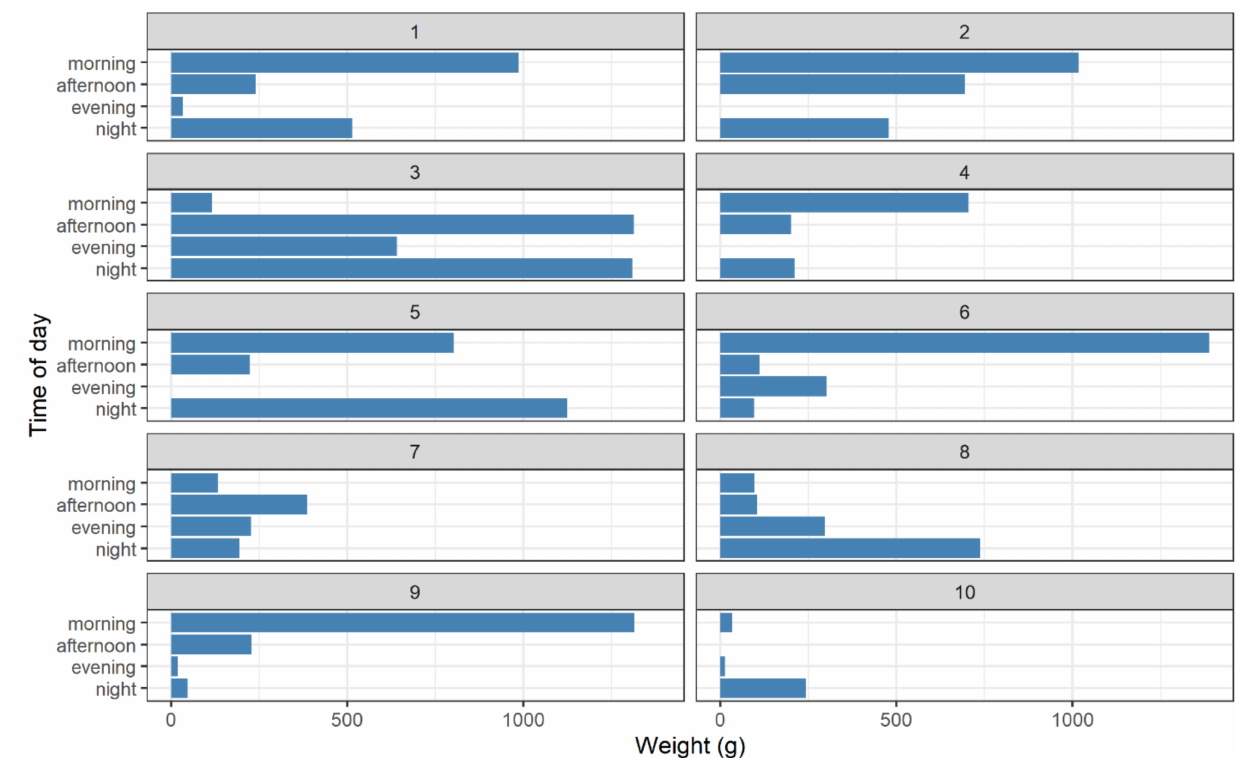
Figure 9. Total weight of waste and time of day across